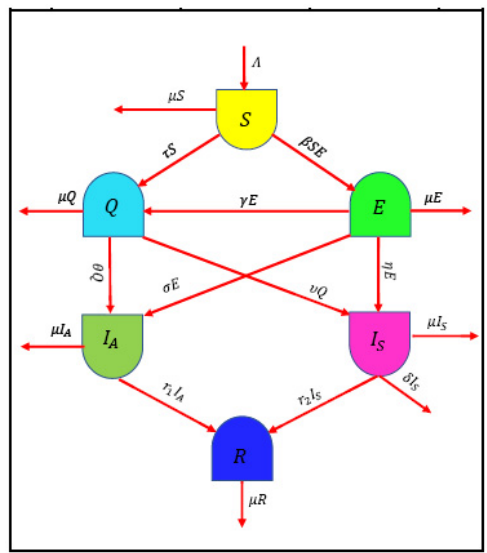
Figure 1. Flowchart describing the dynamics of propagation of the COVID-19